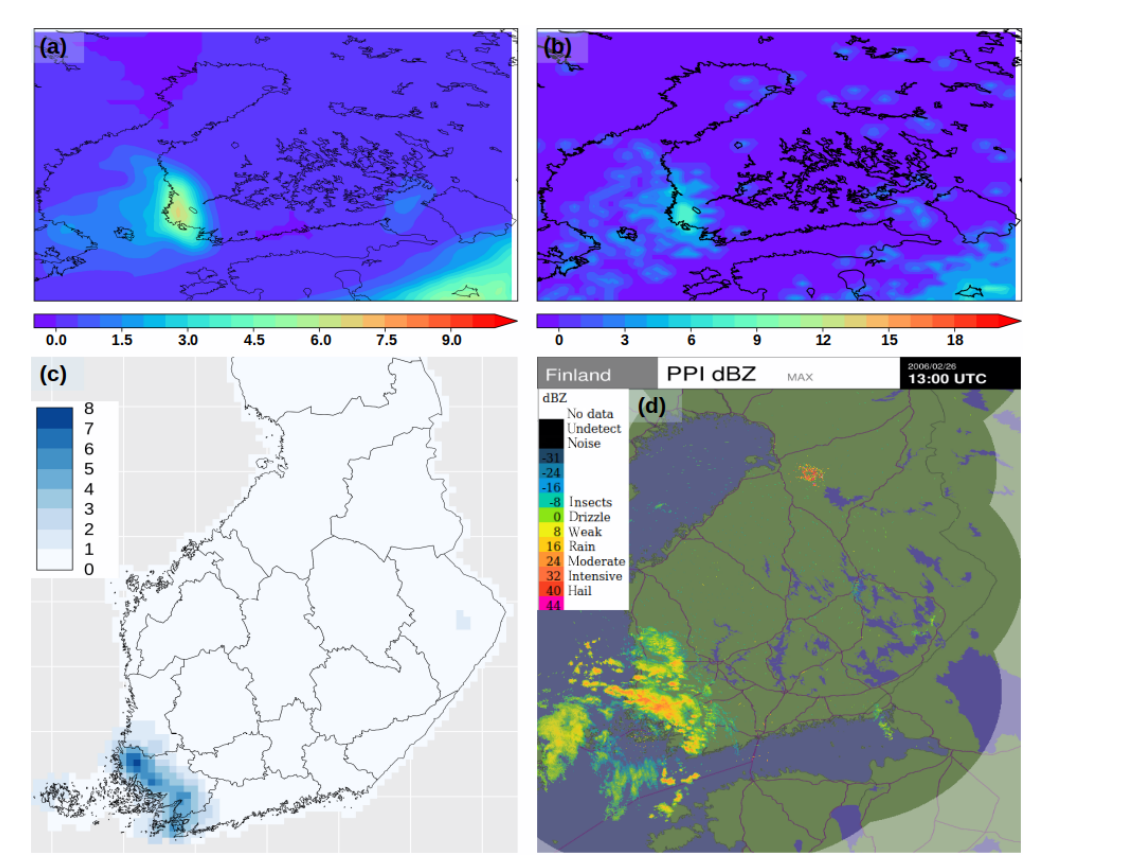
Figure A3. Precipitation on 26 February 2006 from different databases. (a) Accumulated snowfall from RCA4 (mmd − 1 ), (b) total precipi- tation from RCA4 (mmd − 1 ), (c) total precipitation from FMIClimGrid (mmd − 1 ), (d) radar reflectivity factor (dBZ) image at 13:00UTC.